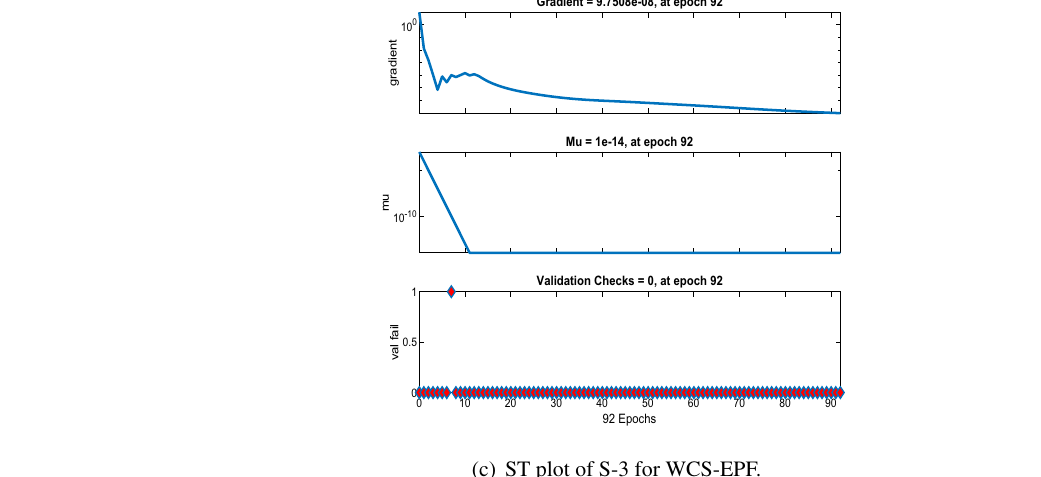
(c) ST plot of S-3 for WCS-EPF.